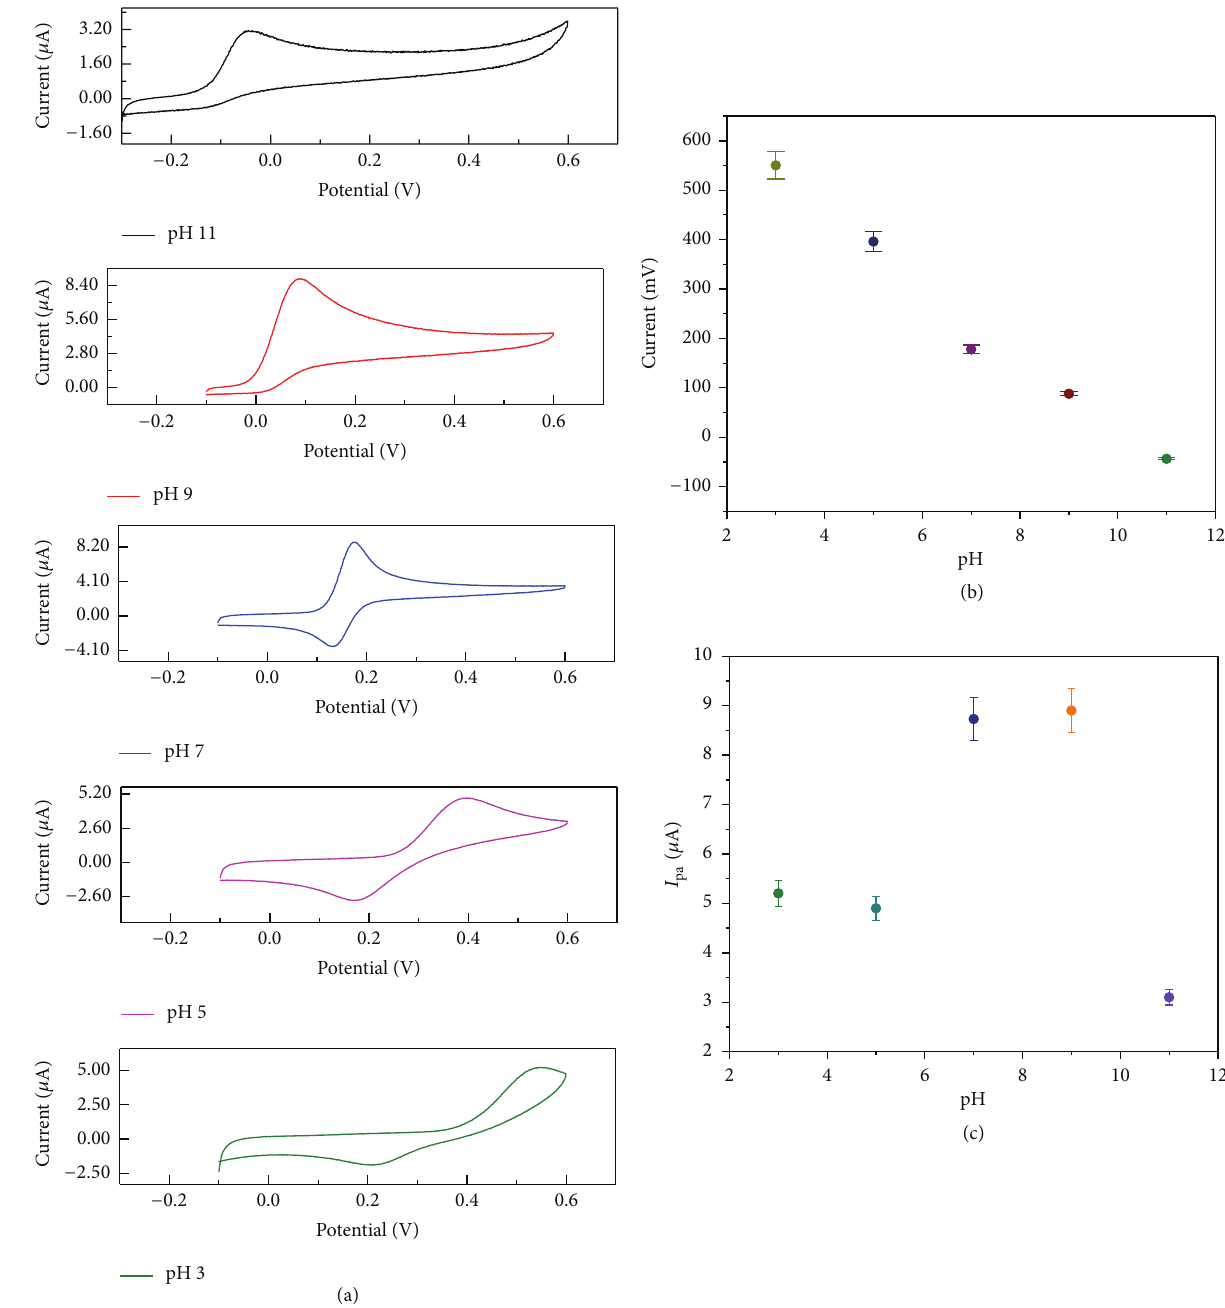
Figure 11: (a) Cyclic voltammograms recorded at 𝛼 -Fe 2 O 3 nanoparticle-modified electrode for 50 𝜇 M of DA in 0.1M PBS with different pH values at scan rate of 50mVs −1 . Plots of (b) anodic peak potential (𝐸